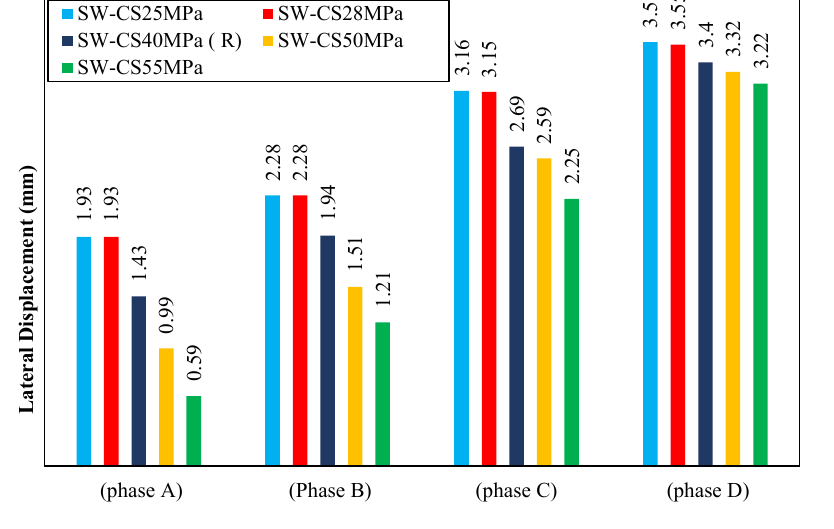
Figure 13. Lateral displacement of group 2.